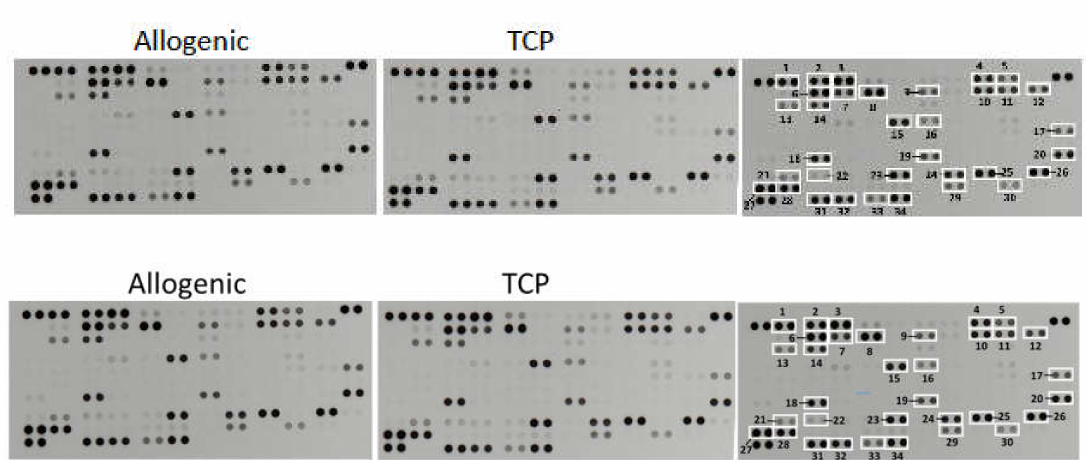
Figure 4. Representative X-ray results of the cytokine array from the cell–tissue composites (Allo vs. TCP) of one patient. The right scheme displays the respective coordinate reference number # for analyte identification. Unframed spots are assay-specific reference